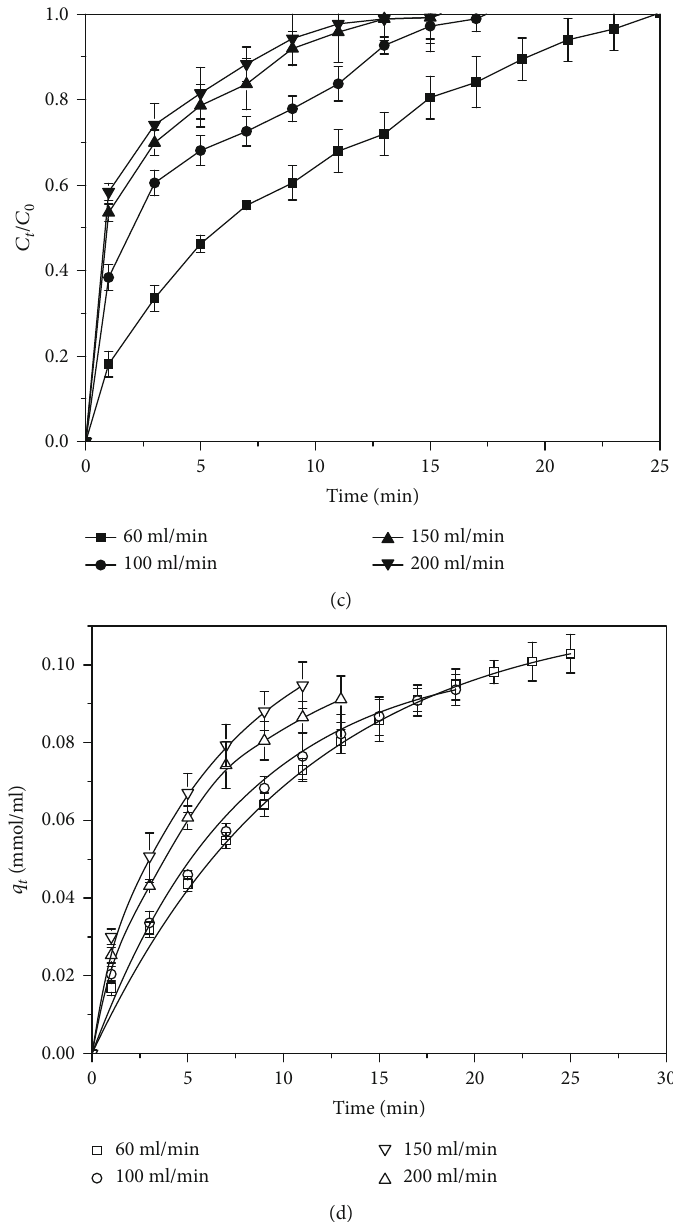
Figure 8: Breakthrough curves and CO gas (c, d). The in fl uence of sorbent fraction was evaluated under the conditions of 5 mol % CO 20 ° C and 101.3kPa. The in fl uences of gas fl ow rate were investigated under the conditions of 5 mol % CO sorbent fraction at 20 ° C and